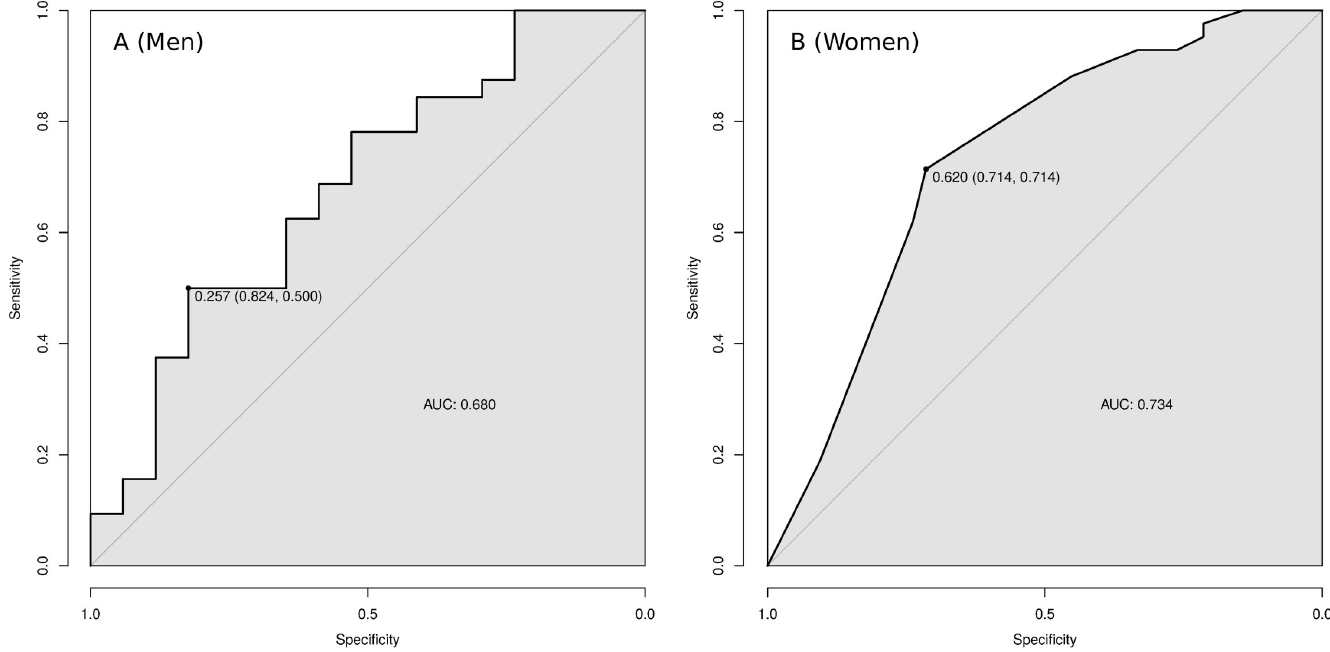
Fig 3. Variables with greater importance for the prediction of attempted suicide by the Random Forest algorithm according to gender. The top ten variables out of the 27 for men (A) and the three variables for women (B) are shown.